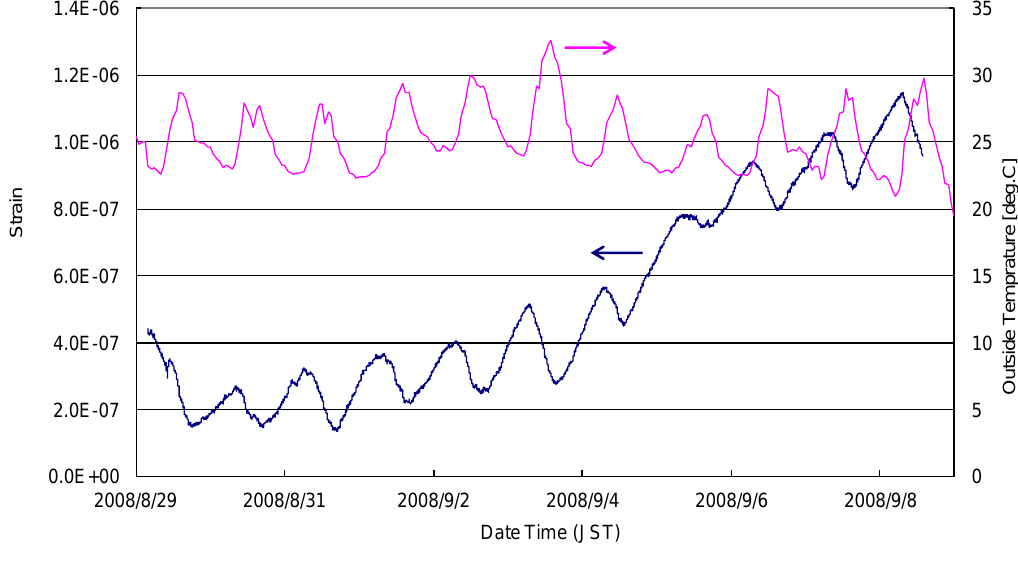
Figure 4. Coincidence between the displacement of the tunnel and the outside temperature. The blue line shows the displacement of the tunnel and the pink line shows the outside